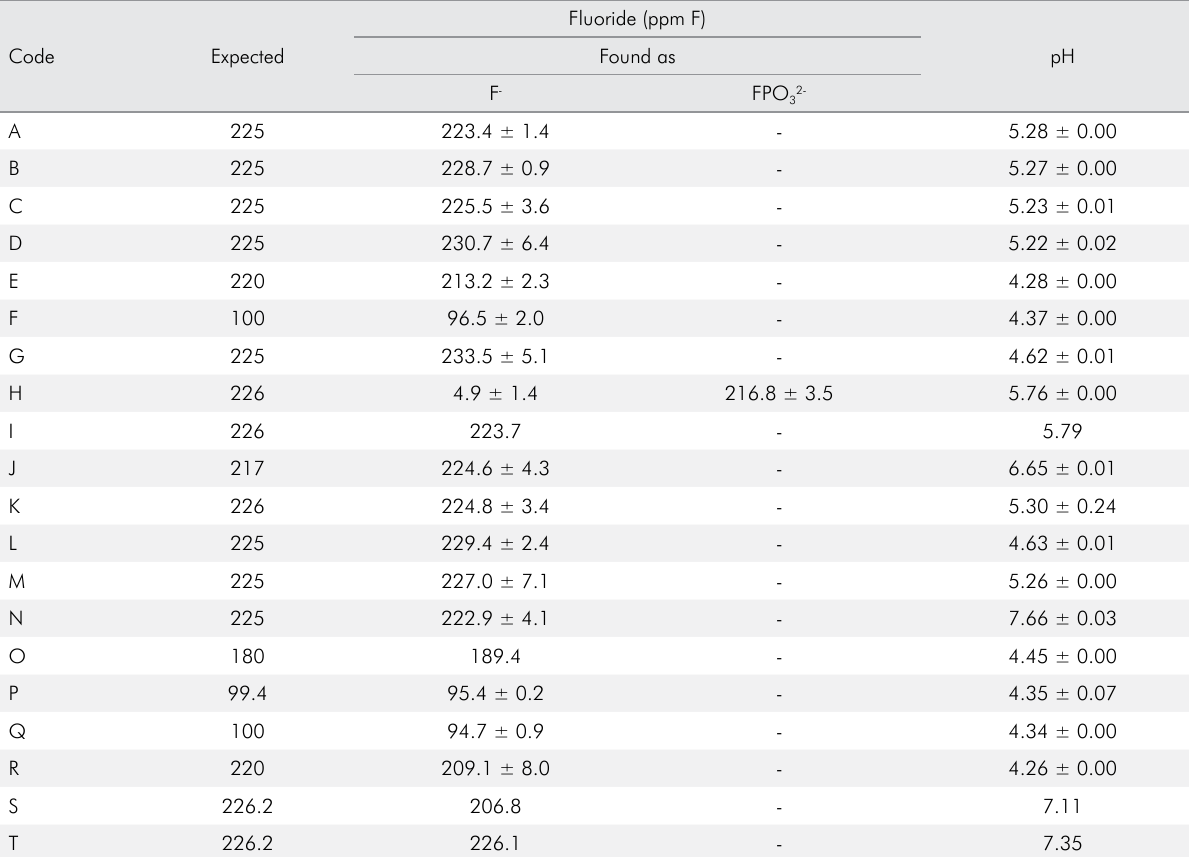
Table 3. Mean (±SD) fluoride concentration (ppm F) expected and found as the fluoride ion and the FPO 32 ion, and pH of the mouthwashes (n = 3; except mouth rinses G and J, n = 2; I, O, S and T, n =